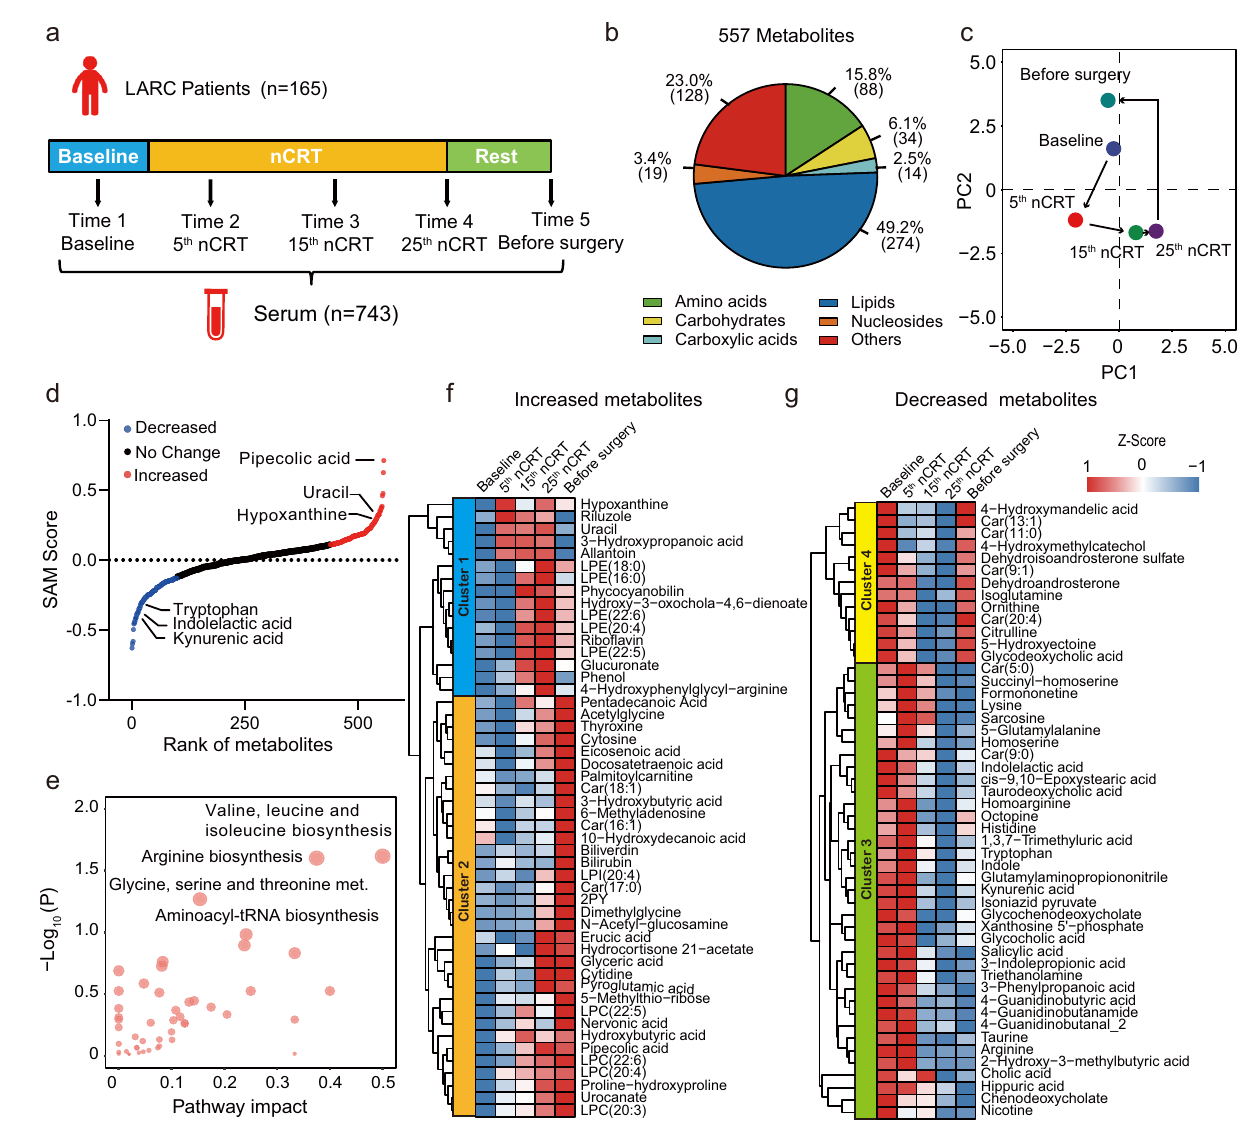
Fig.1|SerummetabolictraitsinresponsetonCRTinLARCpatients.a Overview of the clinical design of the metabolomics study. b Number of identi fi ed metabo- litesinserumsamplesanddistributionsofchemicalclasses. c Principalcomponent analysis (PCA) shows signi fi cantly altered metabolic pro fi les over the course of nCRT.Eachdotrepresentstheaveragedvaluefromallpatients. d Metaboliteswere signi fi cantly associated with the nCRT treatment analyzed by SAM (Signi fi